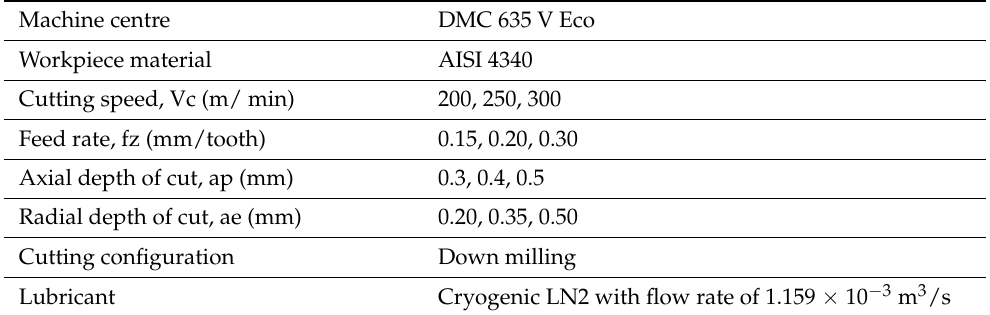
Table 3. Cutting